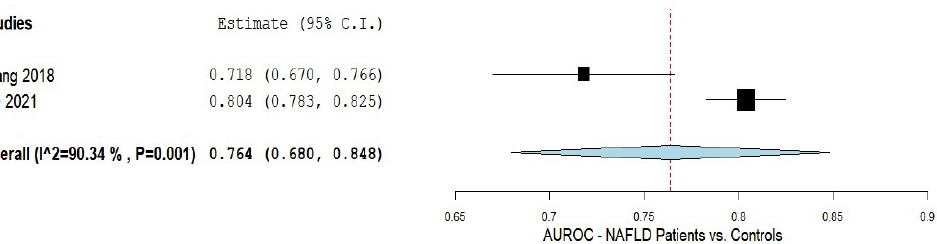
Figure 4. The accuracy of the AIP in predicting NAFLD. AIP—Atherogenic index of plasma; NAFLD—Non-alcoholic fatty liver